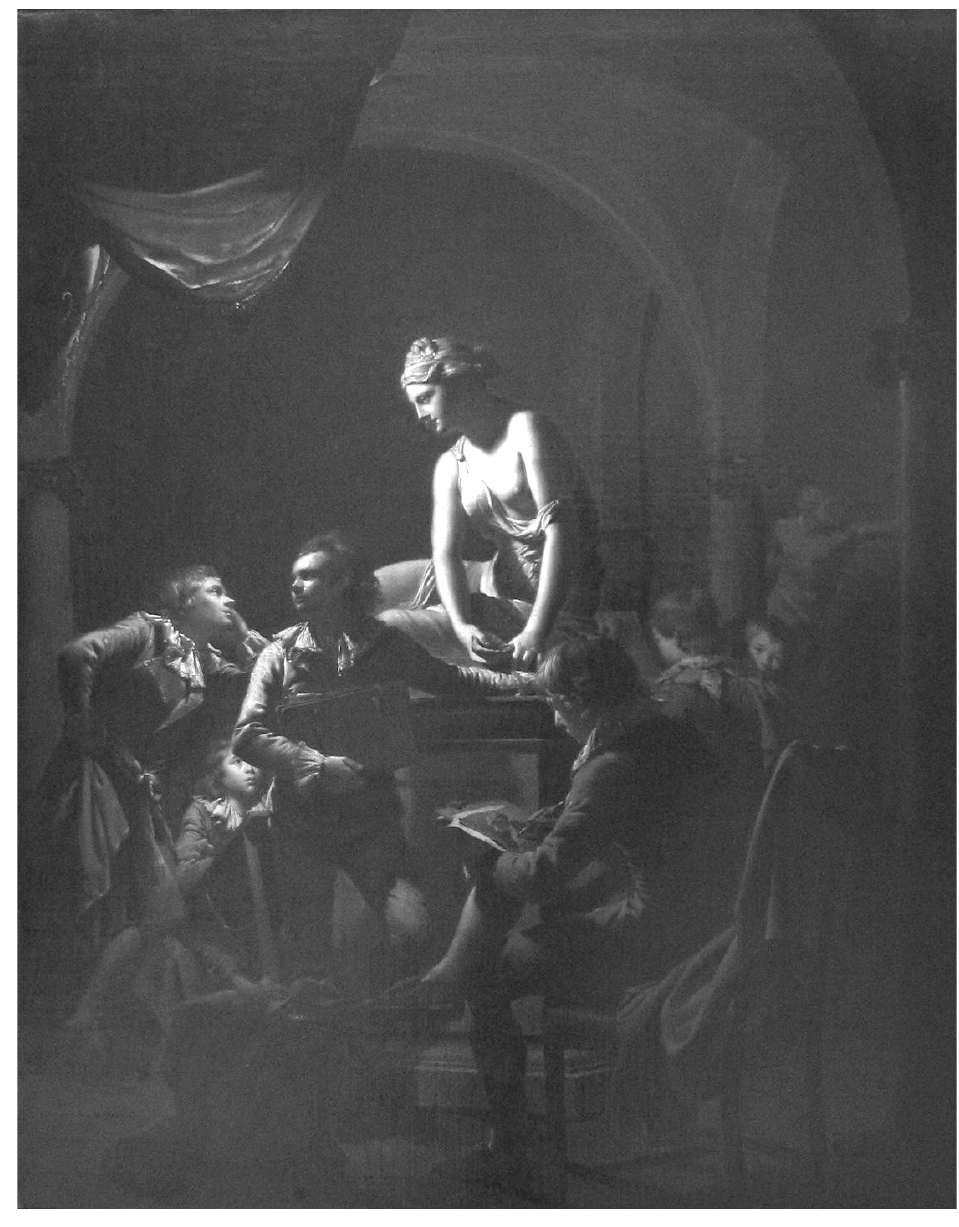
Figure 3 Joseph Wright of Derby, An Academy , 1769. Oil on Canvas, 127x101.2cm. Yale Centre for British Art (photo: Wikimedia